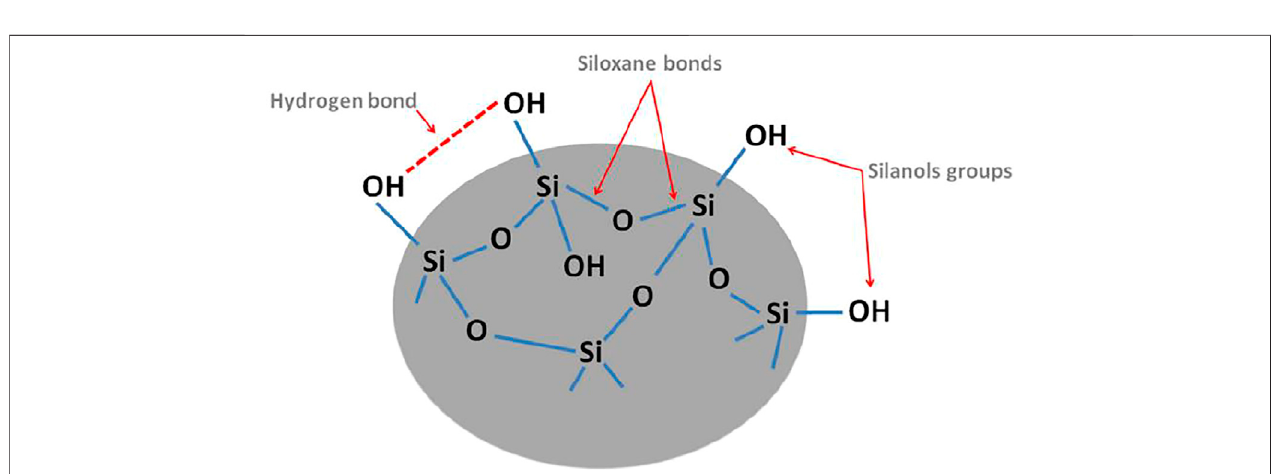
FIGURE 6 | The structure of diatomite surface and their silanol groups and the types of bonds.